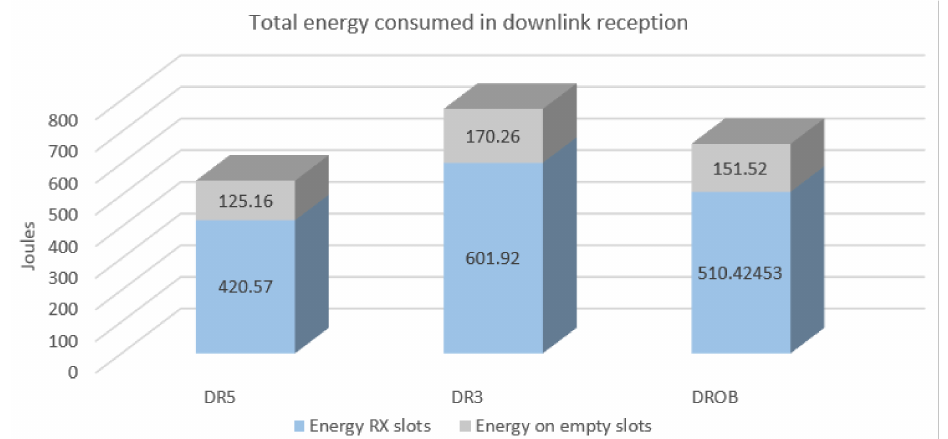
Figure 15. Energy consumed by the whole network during 24